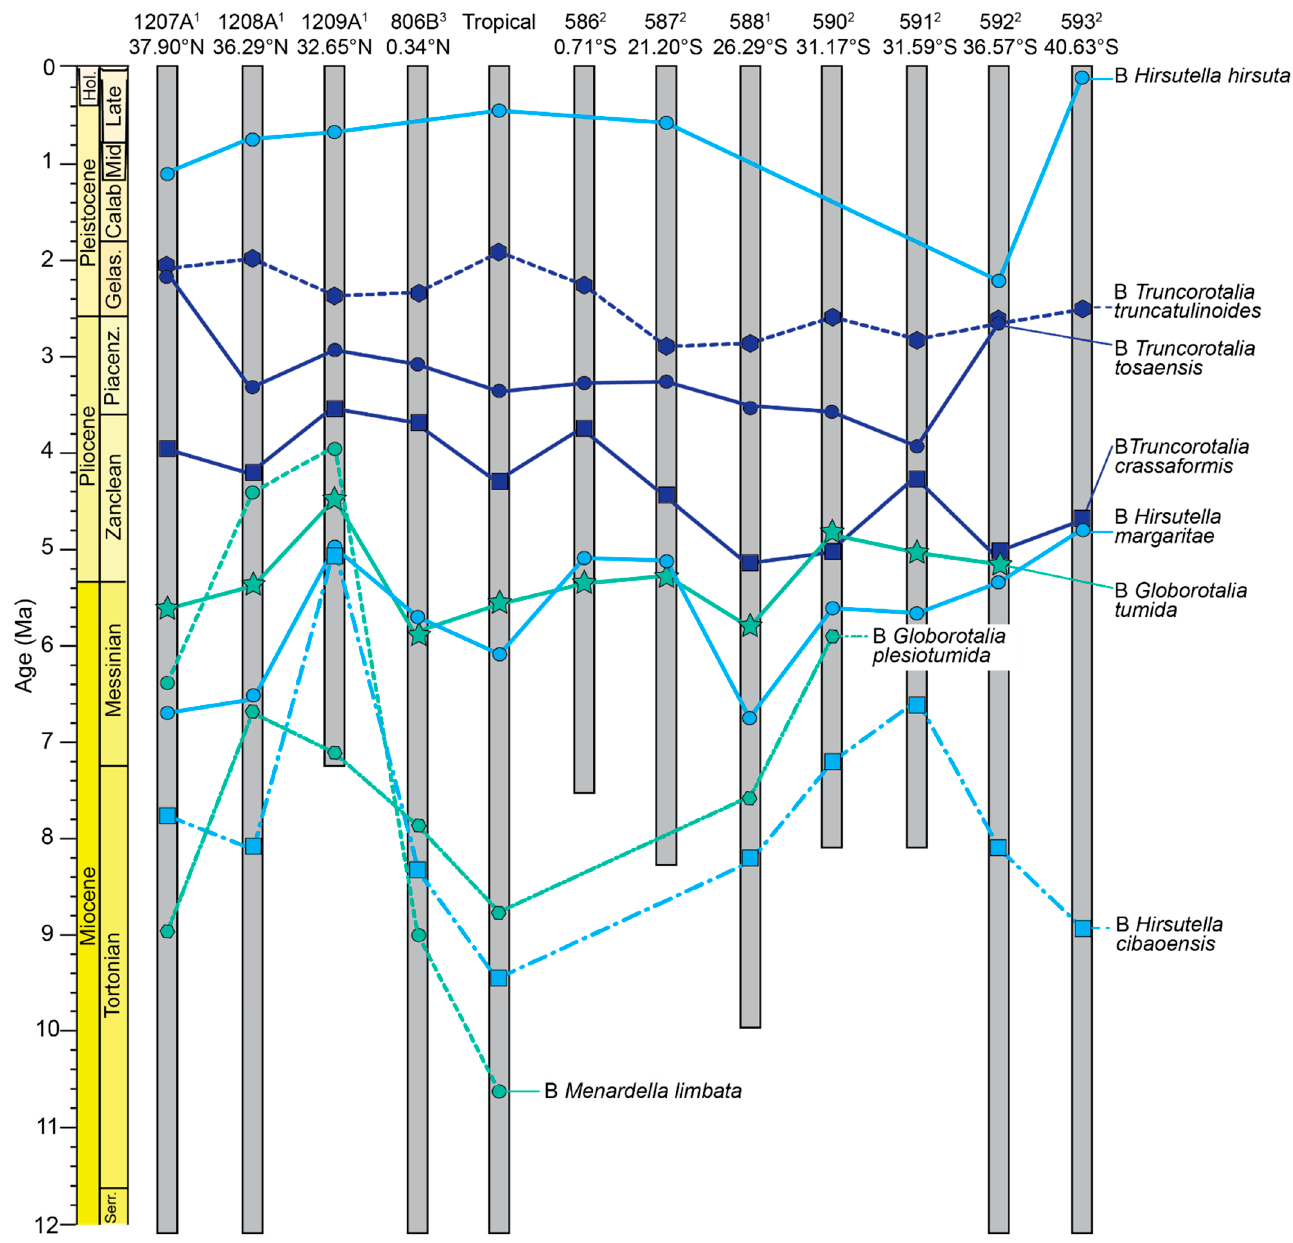
Figure 7. First occurrences of species used as primary and secondary datums in tropical-to-mid- latitude biostratigraphic zonations belonging to the genera Truncorotalia, Hirsutella , Globorotalia , and Menardella . Sites are ranked 1–3, as denoted by the superscript number beside each site number. A ranking of 1 indicates that the sites’ age model is based solely on magnetostratigraphy, a ranking of 2 indicates that the sites’ age model is a mix of magnetostratigraphy and biostratigraphy, and a ranking of 3 indicates that the sites’ age model is based solely on biostratigraphy (Supplementary Table S1).